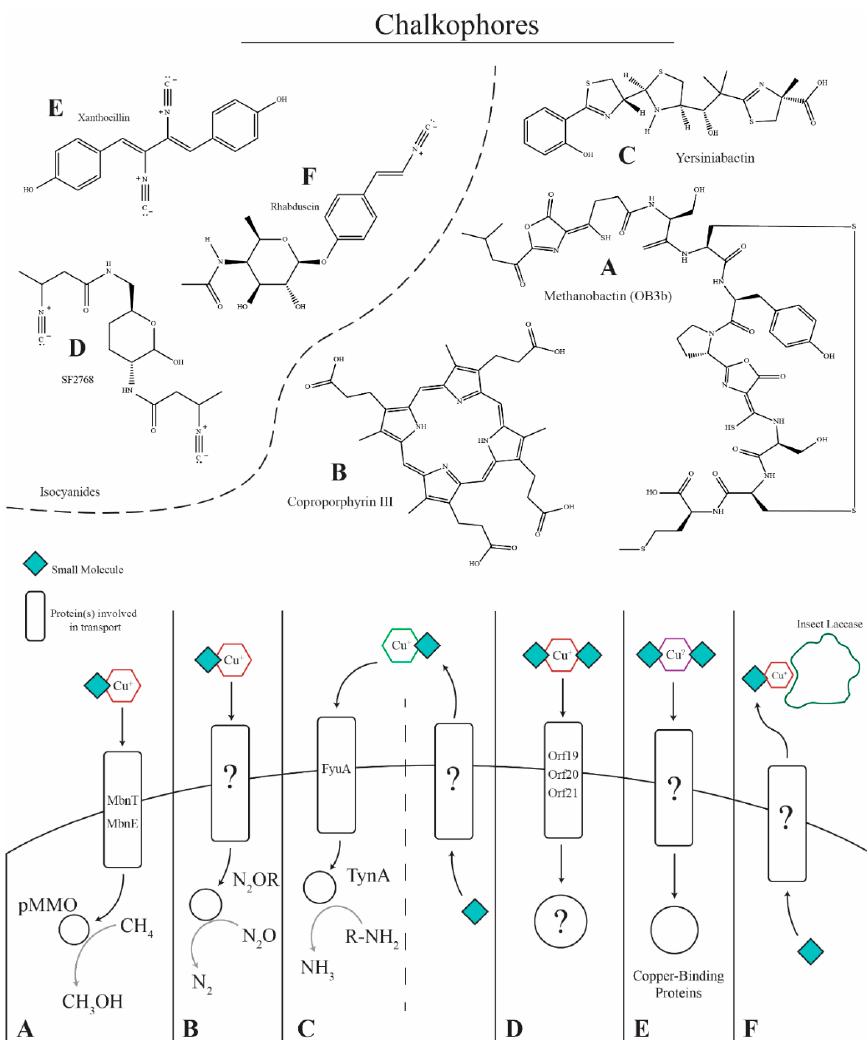
Figure 2. Copper-binding small molecules. ( A ) Methane-oxidizing bacteria such as Methylosinus trichosporium OB3b produce methanobactins to acquire copper for the particulate methane monooxygenase (pMMO) enzyme. Methanobactin is secreted via an unidentified mechanism, binds copper in the environment, and is transported into the cell via MbnT and MbnE for delivery to pMMO for the oxidation of methane to methanol. ( B ) Paracoccus denitrificans produces the chalkophore coproporphyrin III that is transported via an unknown mechanism to bind copper in the environment and deliver it into the cell for use in nitrous oxide reductase. ( C ) Yersiniabactin is produced by bacteria containing the Yersinia high pathogenicity island (HPI) and is implicated as a virulence factor for enteropathogenic Escherichia coli , binding copper and preventing it from damaging the pathogen. The compound also acts as a chalkophore, being required for copper sufficiency, binding copper in the environment and transporting it into the cell for the amine oxidase, TynA. ( D ) Streptomyces thioluteus has been shown to produce the isocyanide chalkophore SF2768 that is required for copper uptake. The chalkophore is produced and transported via putative transporter proteins, binds copper, and transports it back into the cell. ( E ) The isocyanide xanthocillin and xanthocillin-like derivatives produced by A. fumigatus are proposed to act as chalkophores, where they are secreted by an unknown mechanism, bind copper in the environment, and transport it back into the cell for use in copper-dependent enzymes such as cytochrome c oxidase, nitrite reductase, amine oxidase(s), superoxide dismutase (SOD1), and laccases(Abr1/Abr2). ( F ) The insect pathogen Xenorhabdus nematophila produces the isocyanide, virulence factor rhabduscin, which inhibits the copper-dependent insect laccase. The laccase is essential for producing melanin, a component of the insect immune